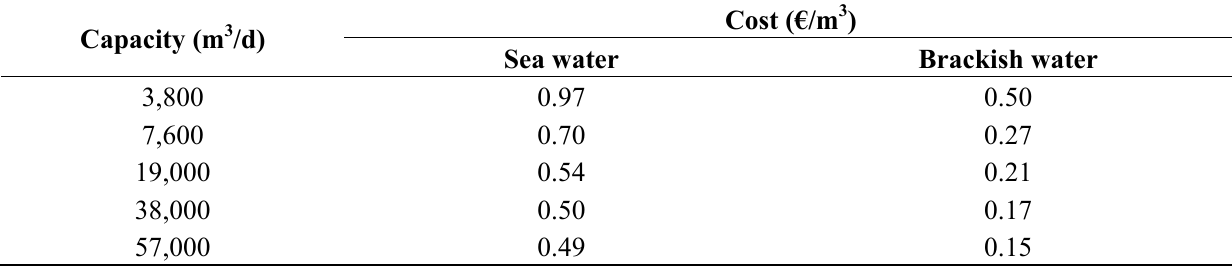
Table 4. Desalinated water production cost from seawater and brackish water.